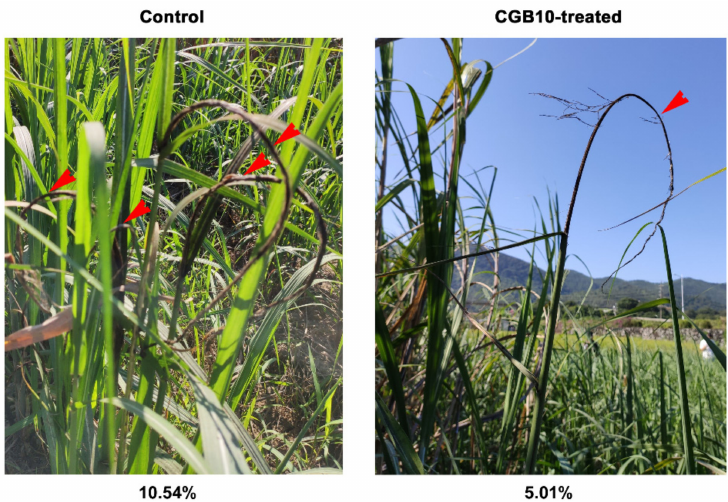
Figure 3. Field trial of CGB10 against sugarcane smut. Red arrows denote multiple black whips from a single clump of canes. Disease occurrence (%) was calculated based on the assessment of more than 2000 sugarcanes from approximately 500 clumps and indicated for control or CGB10-treatment